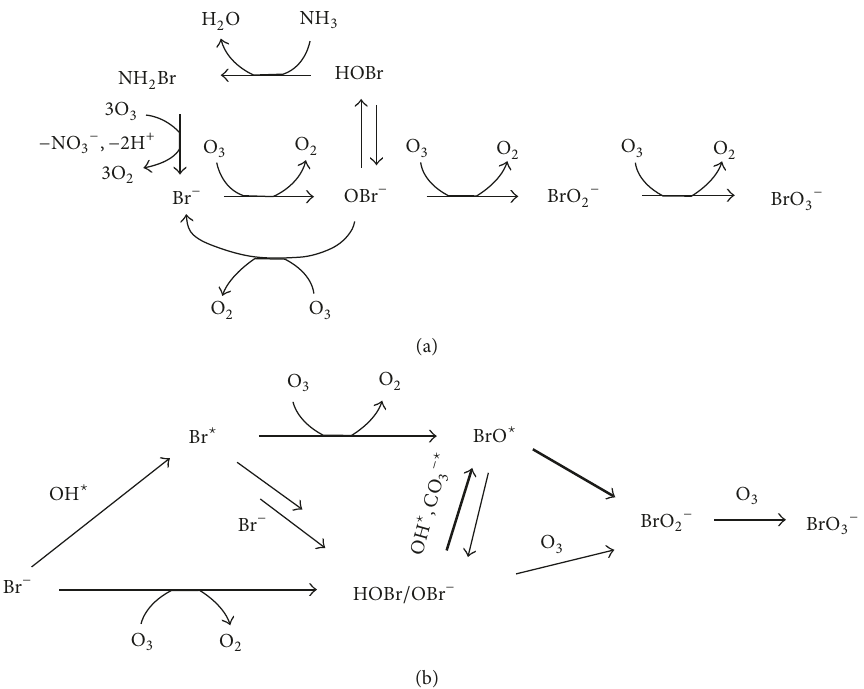
Figure 1: Possible pathways of bromate formation during ozonation of bromide-containing waters: oxidation with (a) O 3 and (b) OH ∙ [1].